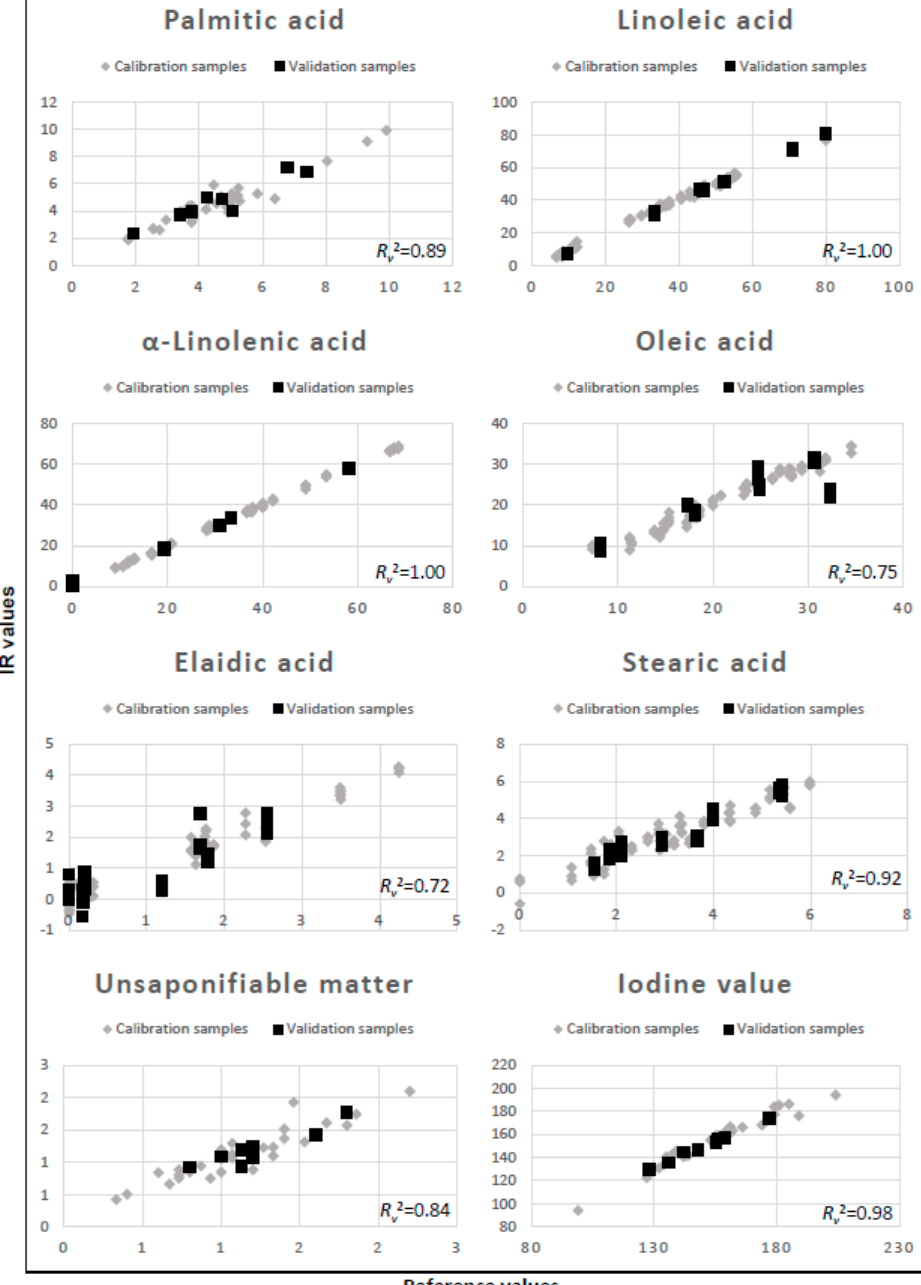
Figure 1. Best results obtained for palmitic, linoleic, α -linolenic, oleic, elaidic, stearic acid, unsaponifiable matter content, and iodine value models; R v 2 values are also given.